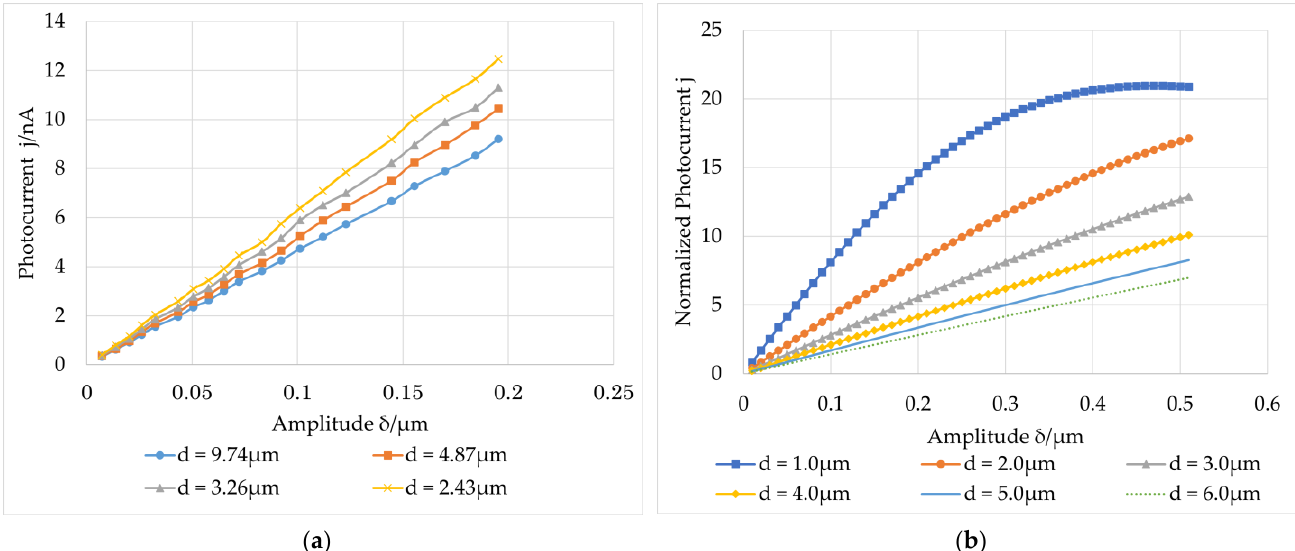
Figure 9. Relation curve between the amplitude of the first harmonic of the photocurrent and amplitude of the vibration at different average speckle sizes: ( a ) experimental results; ( b ) theoretical simulation results.